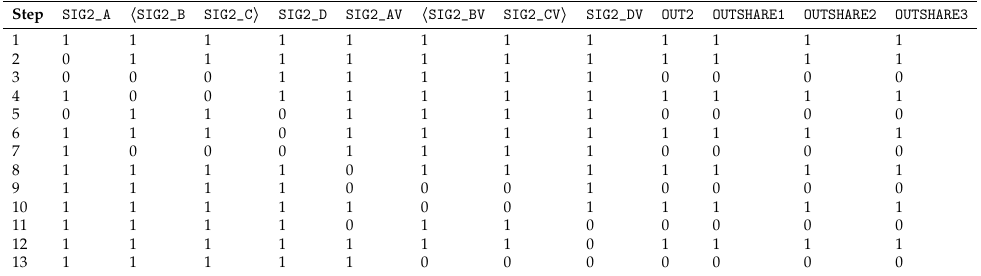
Table 4. Test Case 2—Battery